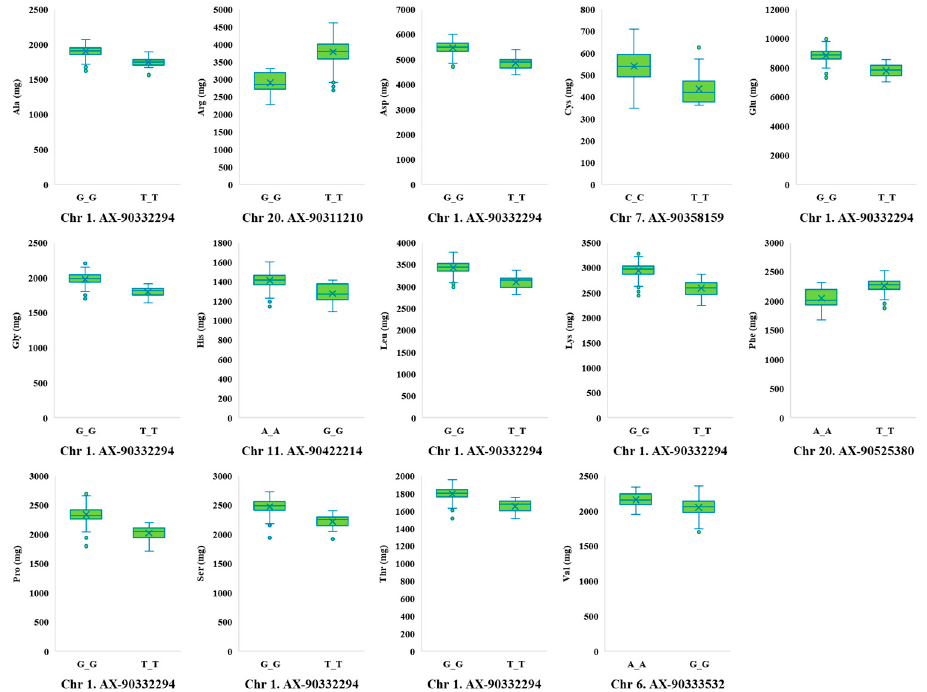
Figure 6. Phenotypic differences between lines carrying different SNP alleles associated with amino acid contents. Asp, aspartic acid; Thr, threonine; Ser, serine; Glu, glutamic acid; Pro, proline; Gly, glycine; Ala, alanine; Cys, cysteine; Val, valine; Leu, leucine; Phe, phenylalanine; His, histidine; Lys, lysine; Arg,